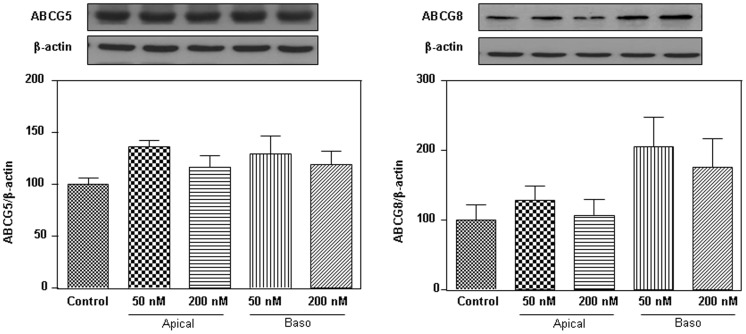
Effects of the administration of PYY (1–36) to the apical or basolateral medium on the protein expression of ABCG5 and ABCG8.Caco-2/15 cells were cultured for 24 h in MEM as described in the legend of Figure 2. Western blot was used to analyse the protein expression of ABCG5 (A) and ABCG8 (B). Data represent means ± SD for n = 3 separate experiments in each group and are reported as % of control values representing 100%.